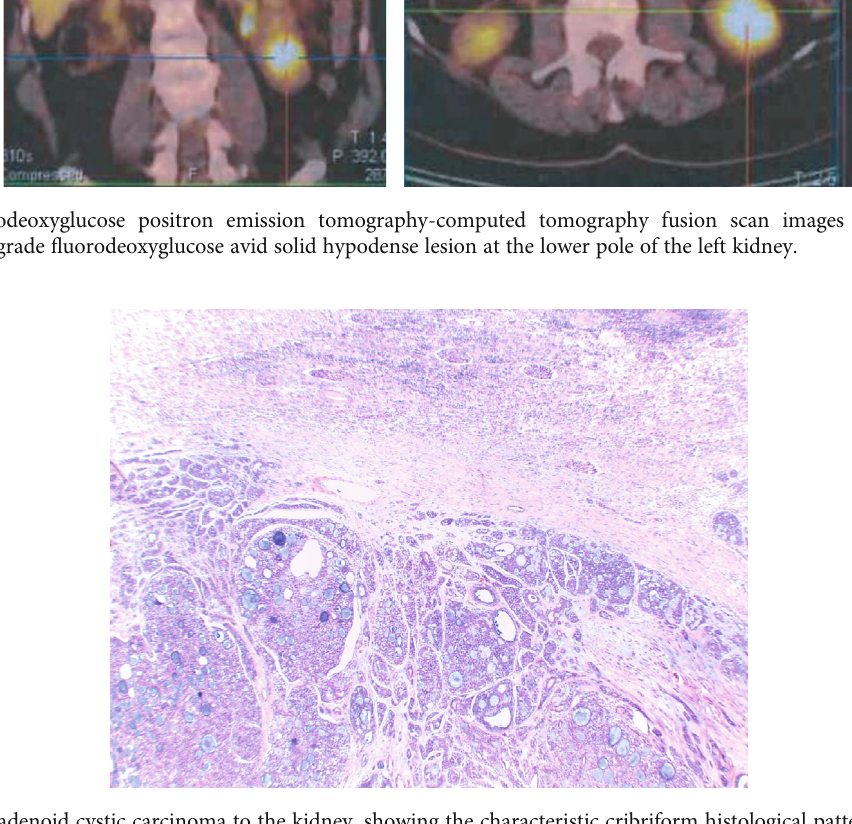
Figure 3: Metastatic adenoid cystic carcinoma to the kidney, showing the characteristic cribriform histological pattern of growth. Normal renal parenchyma is seen at the upper half of the image (haematoxylin-eosin stain, original magni fi cation